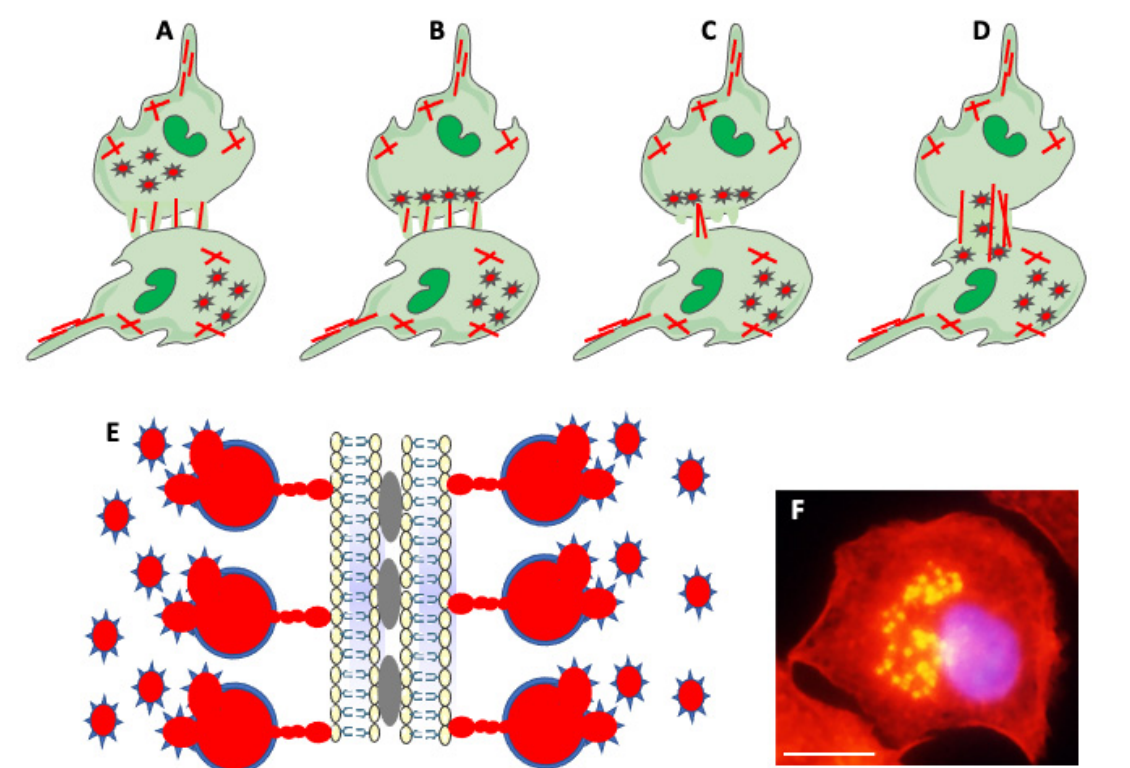
Figure 5. Actin-based structures in cell adhesion and fusion. ( A ) After establishing a fusion area between fusing partners, the cell-initiating fusion extends different size actin-based (red lines) pro- trusions at its edge. ( B ) Podosomes (stars), consisting of actin center (red) and peripheral adhesion proteins (blue), of the fusion-initiating cell migrate from the cell interior to the pre-fusion area. ( C ) One of the protrusions (usually the longest) acts as a fusopod-initiating fusion and creates the fusion pore. ( D ) Reorganization of actin filaments expands fusion pore, allowing migration of podosomes from donor to fusion partner (Modified from Faust et al., Ref. [42]). ( E ) Zipper-like structures (ZLSs) at the surface of adhering MGCs formed in response to foreign materials. Membranes of adjacent cells adhere via adhesion proteins (gray ovals). Podosomes (red and blue stars) fuse into giant actin globules (red) surrounded by adhesion proteins (blue) and attached by smaller actin globules to the membrane. Actin globules are evenly spaced (resembling the zipper) along the membrane (modi- fied from Balbyev et al., Ref. [105]). ( F ) Image of mouse macrophage showing podosomes (yellow). The nucleus (blue) is stained with DAPI. Actin is stained red with Rhodamine-Phalloidin; podosomes look yellow because of the high actin concentration and image overexposure. The magnification bar is equal to 10 μ m.